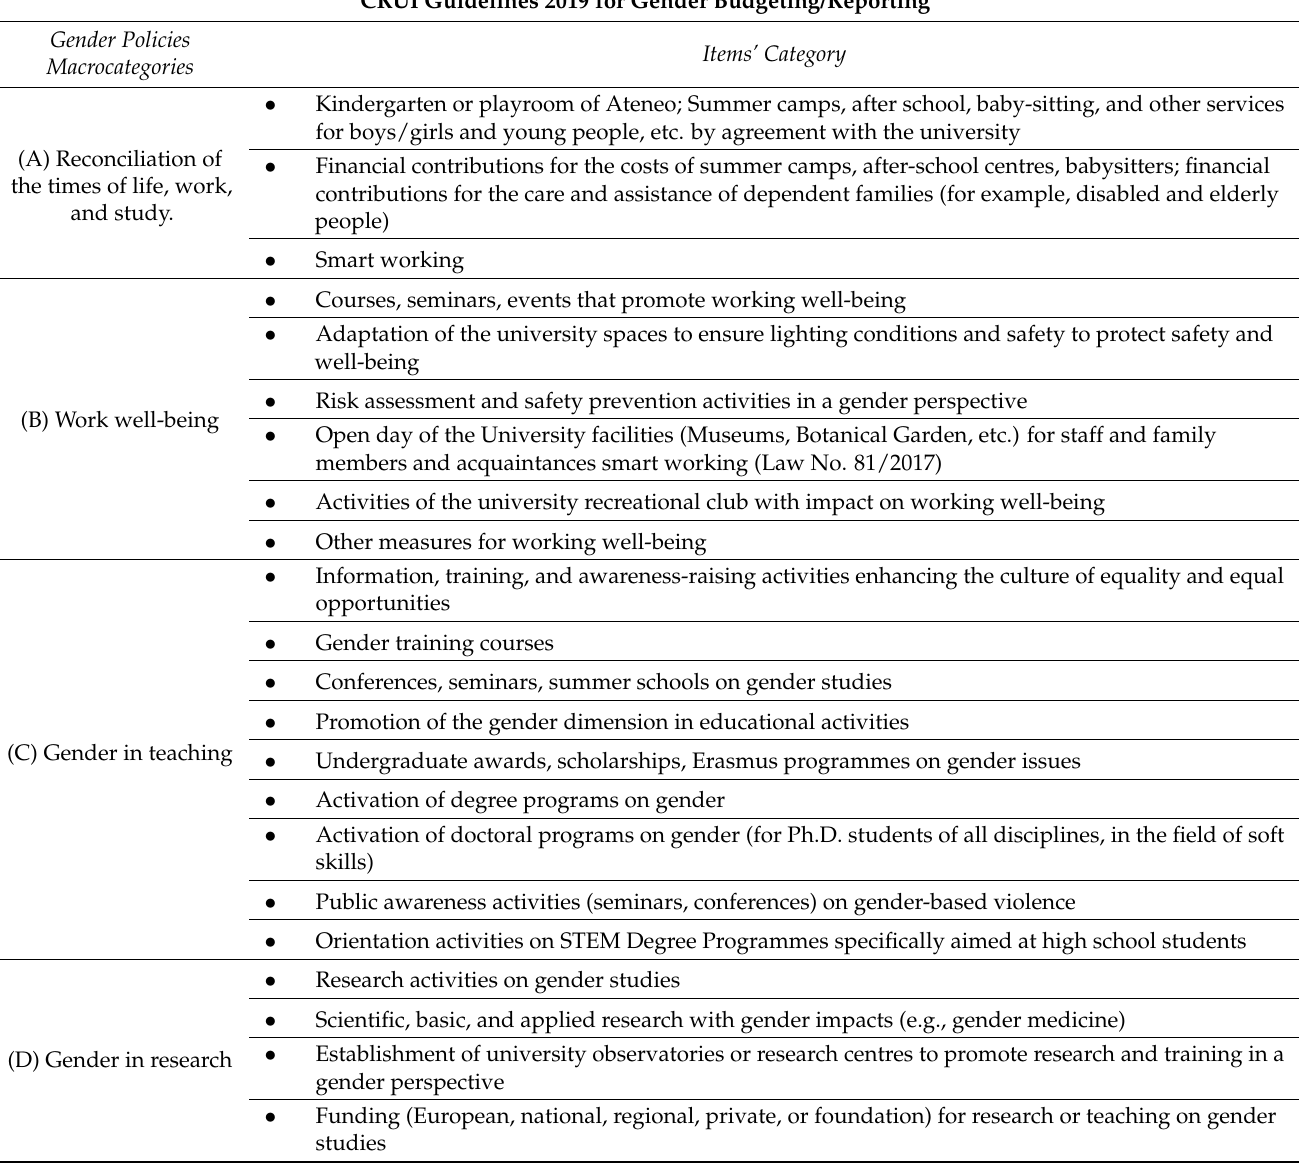
Table 2. Information Items about the gender polices according to the CRUI Guidelines. CRUI Guidelines 2019 for Gender